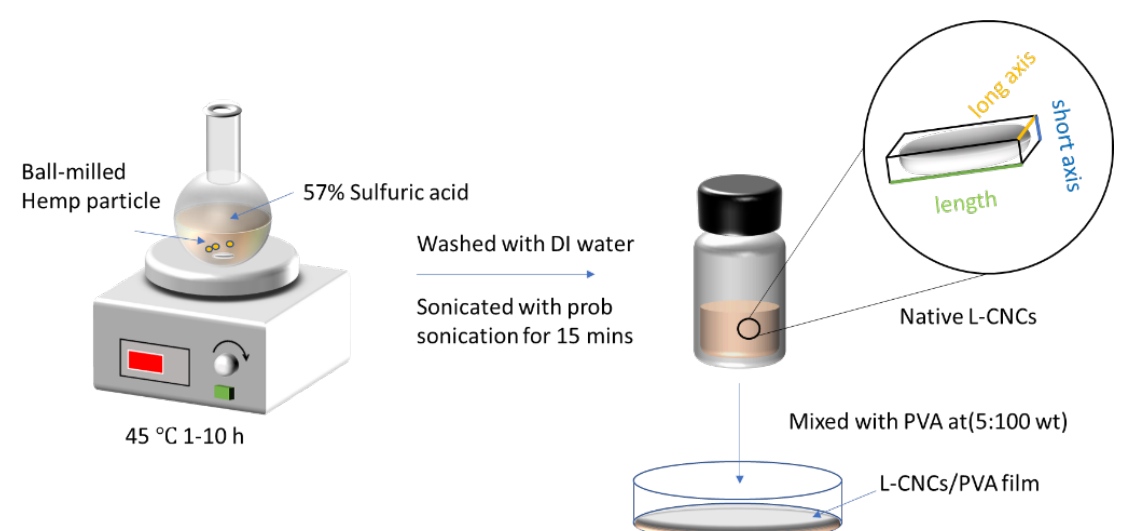
Figure 1. Schematic of fabricating lignin – cellulose nanocrystals at 45 °C and 10 hr hydrolysis time (L-CNCs10) and its subsequent L-CNCs/PVA (5 wt. %) film.